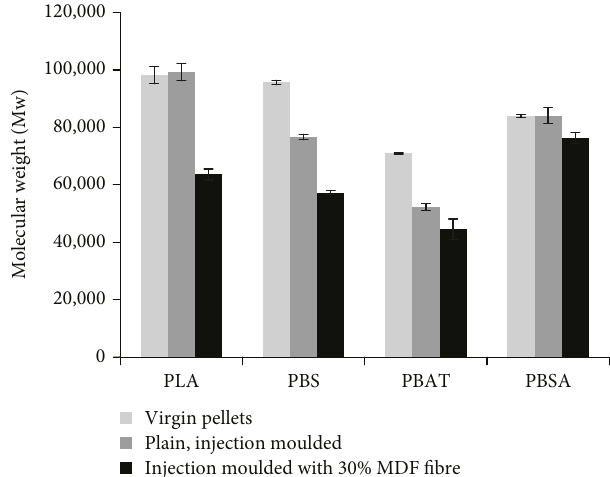
Figure 4: Molecular weight reduction of four biopolyesters before and after extrusion with or without 30 wt % MDF fi bres (error bars = ± 95% con fi dence interval) ( n = 2